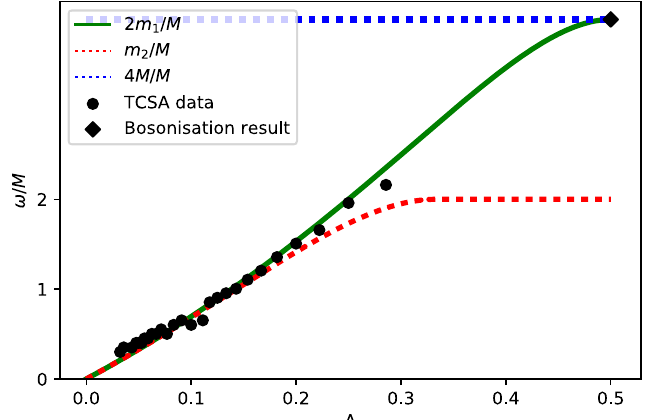
Figure 4 . Oscillation frequencies of the horizon violation e(cid:11)ect. Numerical data from the TCSA and the analytical result at the free fermion point using bosonisation, are compared with several relevant masses present in the theory: twice the mass of the (cid:12)rst breather 2 m 1 , mass of the sec- ond breather m 2 and four times the soliton mass 4 M . The TCSA works best in the small and intermediate (cid:1) regime and becomes progressively less convergent for (cid:1) & 0 :